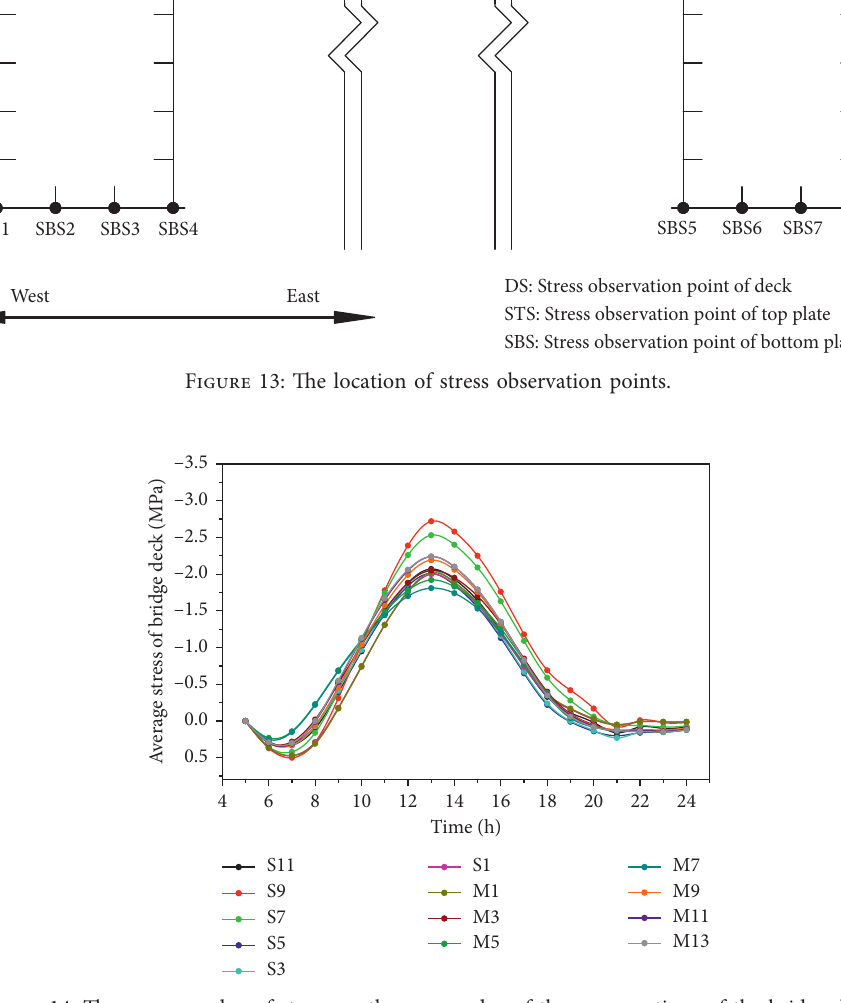
Figure 14: The average value of stress on the upper edge of the cross sections of the bridge